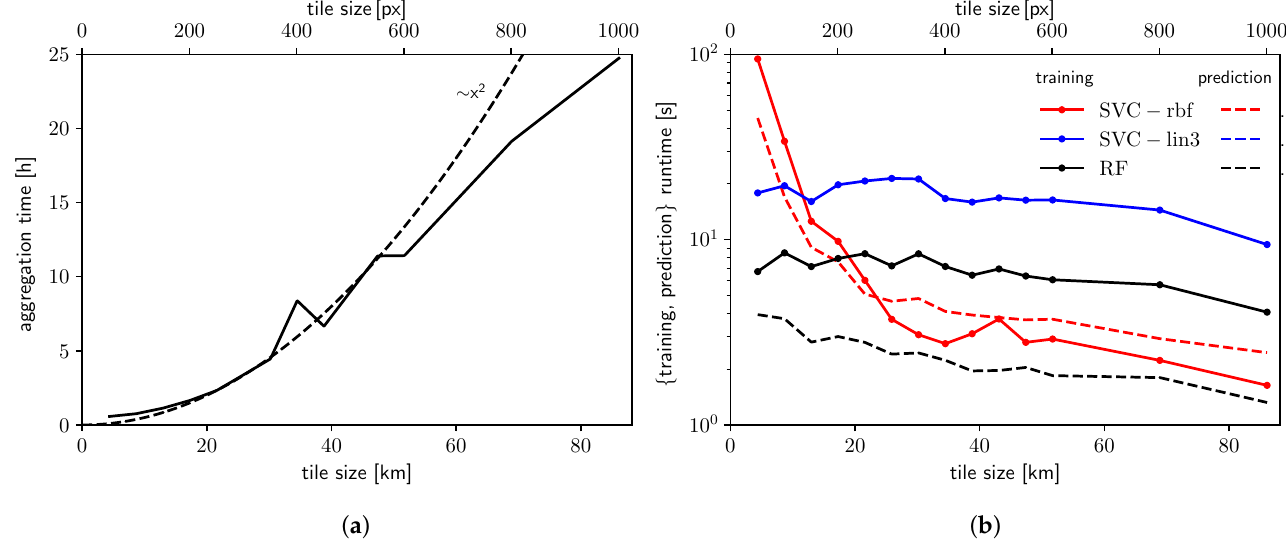
Figure 3. Effect of tile size on ( a ) aggregation and ( b ) training and prediction runtime. Note that, for clarity, we omit- ted prediction runtime for SVC-LIN. It has a similar (lack of) dependency on tile size as RF-100, but is two orders of magnitude